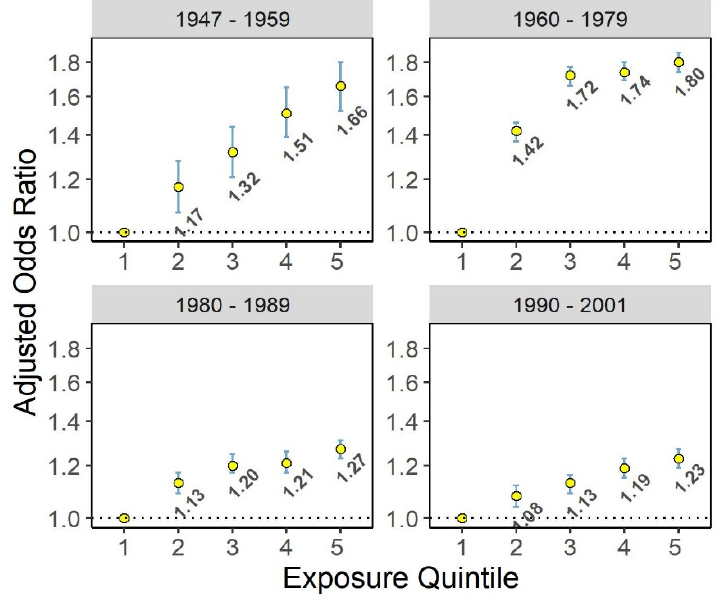
Figure 3. Odds ratios and 95% confidence intervals for exposure to NOx and asthma, stratified by the decade of birth and adjusted for census SES, and school religious orientation. 1959–1947: n = 802 , 140 , cases = 6,002; 1960–1979: n = 910,203, cases = 48,555; 1980–1989: n = 483,787, cases = 41,560; 1990–2001: n = 582,574, cases = 39,789. Exposure categories: 1947–1959: 1 < 2.55 ppb, 2 = (2.55–3.1 ppb), 3 = (3.1–3.67 ppb), 4 = (3.67–4.51 ppb) and 5 = (4.51–21.7 ppb). Exposure categories: 1960–1979: 1 < 5.34 ppb, 2 = (5.34–7.32 ppb), 3 = (7.32–9.58 ppb), 4 = (9.58–12.7 ppb) and 5 = (12.7–81.4 ppb).